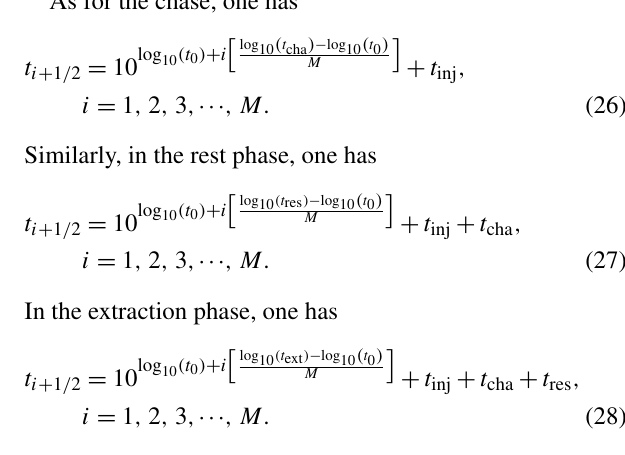
represents the concentration 0